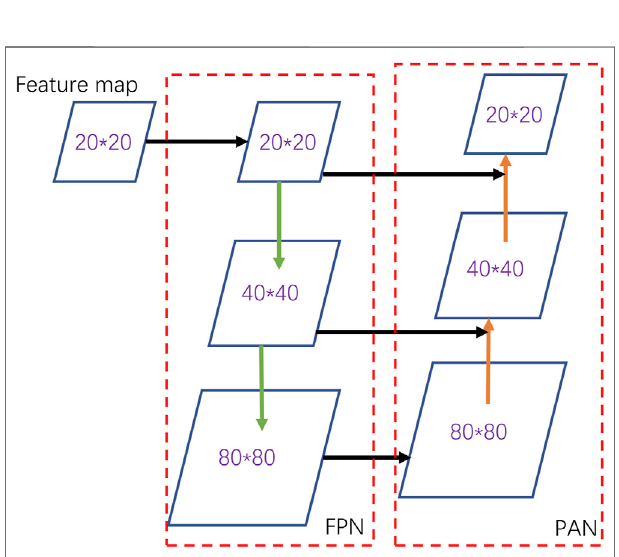
FIGURE 4 | The two feature pyramids (FPN and PAN) in the neck by processing the feature map.